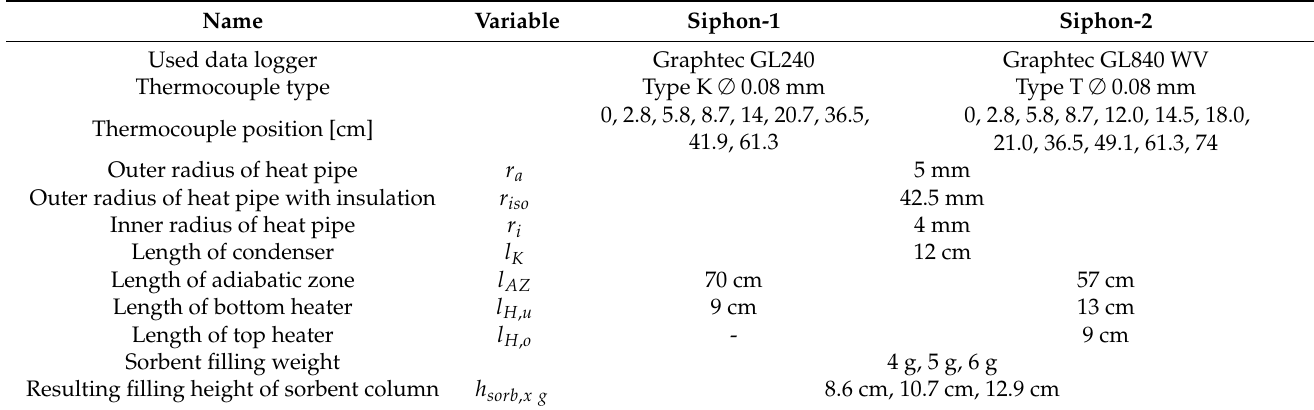
Table 1. Properties of demonstrators Siphon-1 (single heater configuration) and Siphon-2 (double heater configuration). Some of the given variables are used in the equations in the following